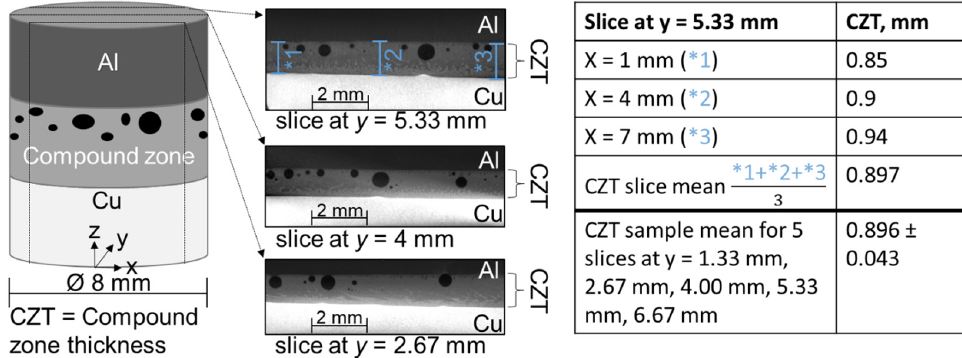
7 of 13 Figure 4. Representative SEM images and corresponding EDX line scans of a cast sample: ( a ) over- view covering the region from Cu to α -Al, ( b ) higher magni fi cation detail focusing on the phases present close to the Cu insert. As described earlier, it was possible to display the compound zone three-dimension- ally over several slices by adjusting the X-ray energy and the positioning of the specimens.